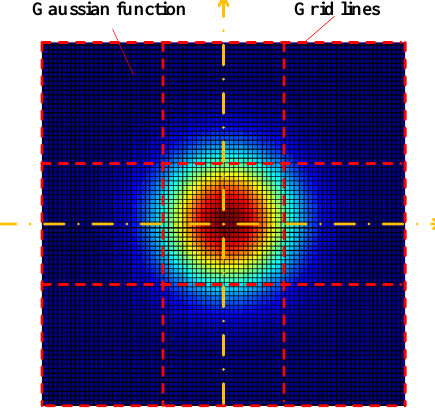
Figure 1. Illustration for obtaining the Gaussian kernel used to describe the effects of jitter. The variance of this Gaussian function should be consistent with the magnitude of jitter.